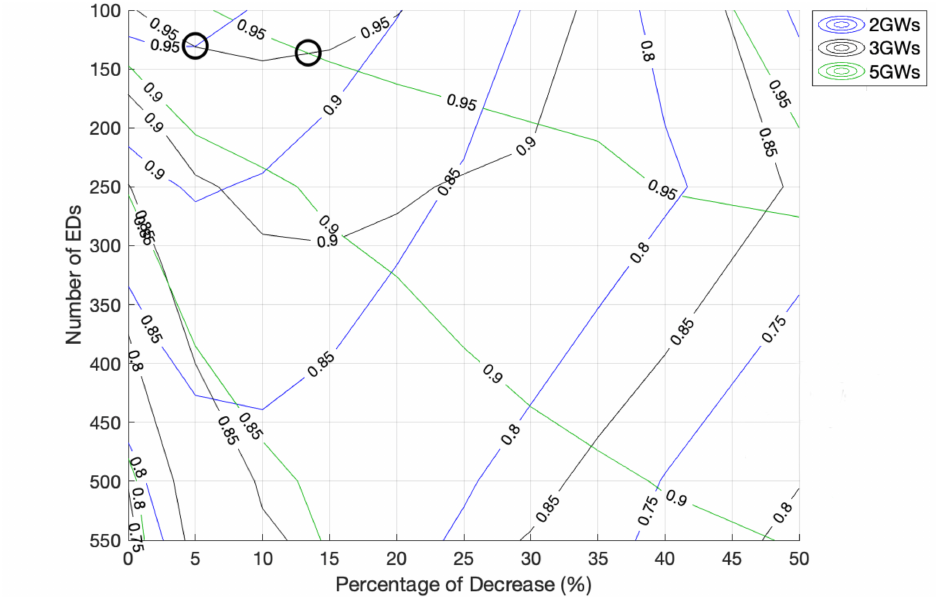
Figure 19. Detailed analysis of the fairness behavior regarding Figure